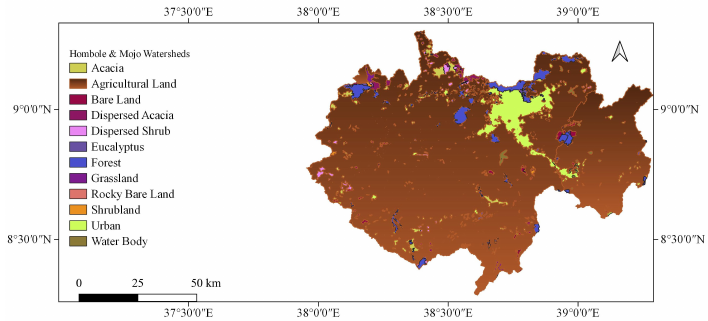
Figure 10. Land use map of the Hombole and Mojo Watersheds from 2001 to 2008.